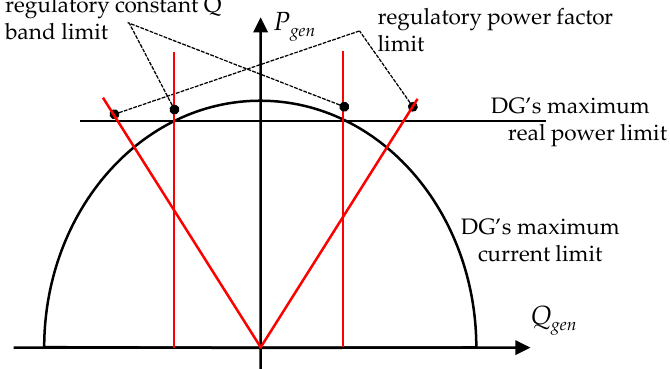
Figure 6. The Renewable Energy Resources (RES) generator’s physical vs. regulatory capability limits.